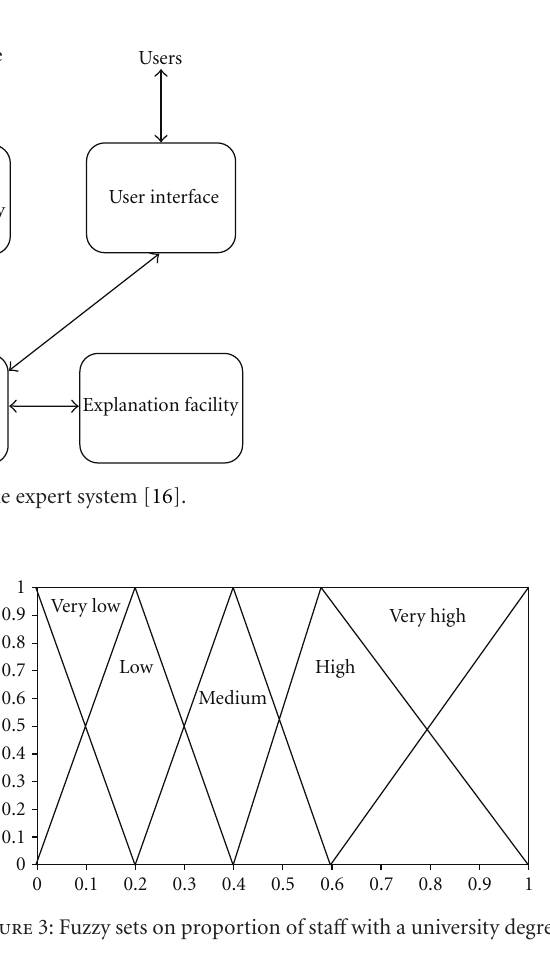
Figure 2: Mamdani fuzzy inference system using min and max for t -norm and t -conorm operators [16].